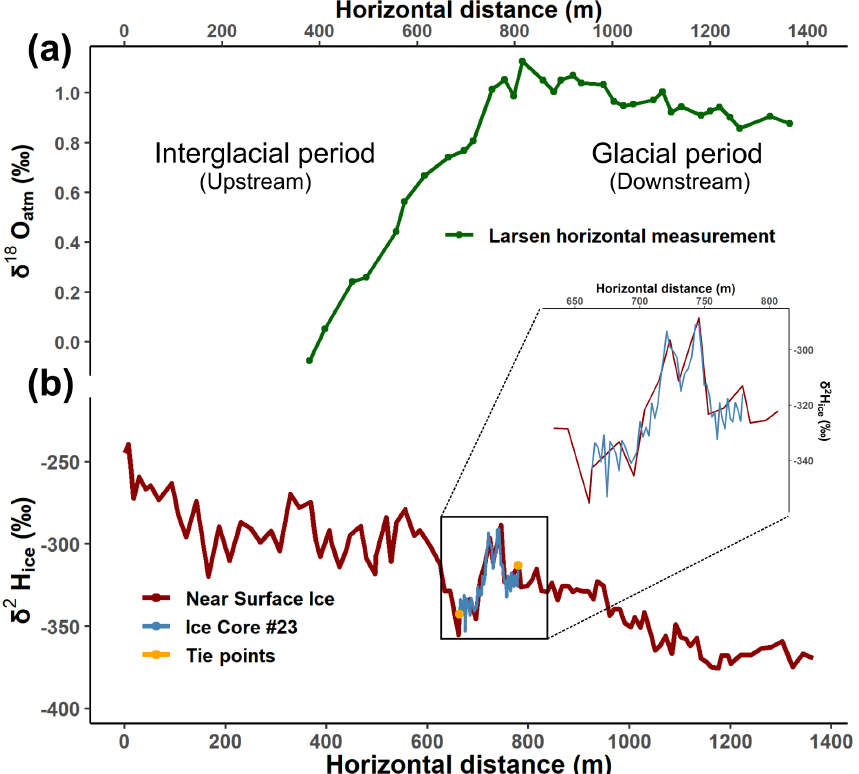
Figure 4. δ 18 O atm and δ 2 H ice records from the Larsen BIA. (a) δ 18 O atm from each ice core at a 1.95m depth (horizontal measurement). The δ 18 O atm of the horizontal measurement was gravity-corrected using Eq. (1). (b) δ 2 H ice from near-surface ice ( ∼ 5–10cm depth surface ice samples and 10–30cm depth ice core samples) and ice core no. 23. The surface ice record was matched with core no. 23 using two tie points (orange dots), with a corresponding r 2 value of 0.86 ( p< 0 . 001).